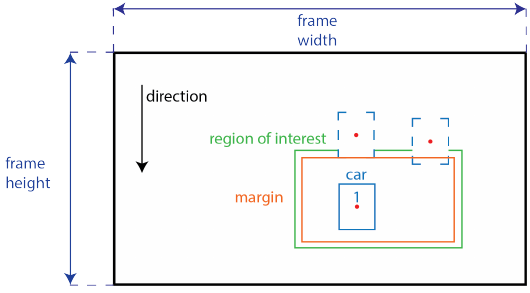
Figure 5. Proposed approach.